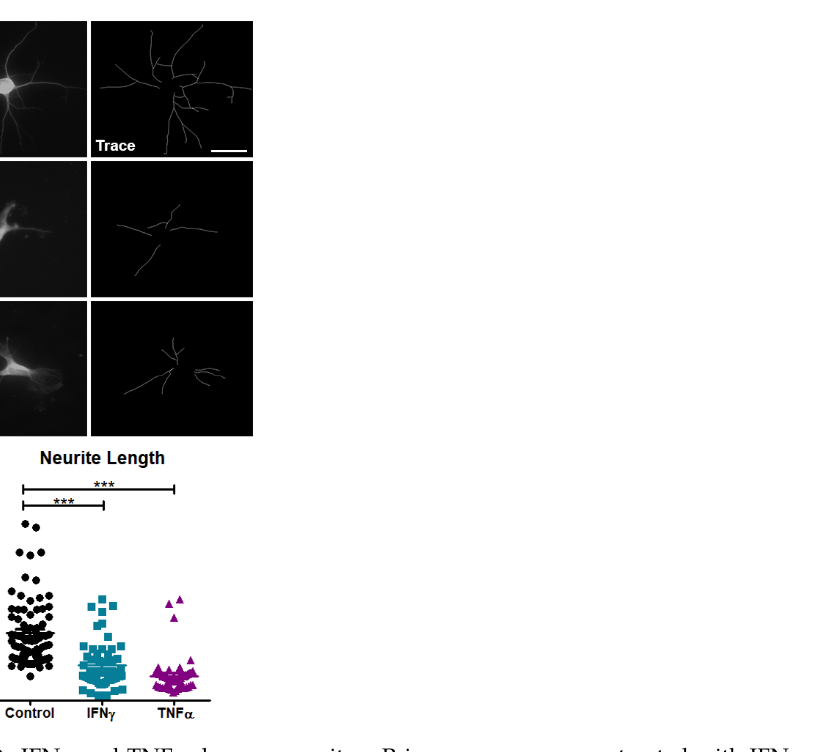
Figure 2. IFNγ and TNFα damage neurites. Primary neurons were treated with IFNγ or TNFα and examined for neurite damage. IFNγ and TNFα led to decreased neurite length as compared to control. One-way ANOVA with Tukey’s post hoc tests with *** p < 0.001. Each dot represents an individual neuron with error bars +/− SEM. Scale bar 20 μm.